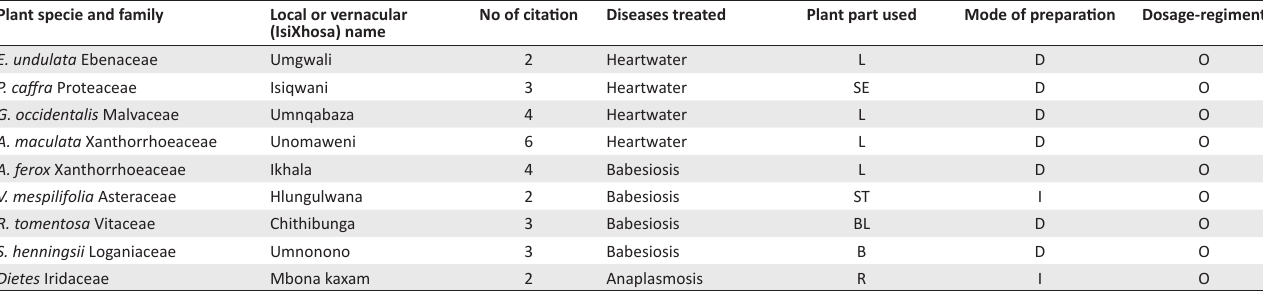
TABLE 1: Ethnoveterinary surveyed medicinal plants of Amathole and O.R. Tambo districts of South Africa. Plant specie and